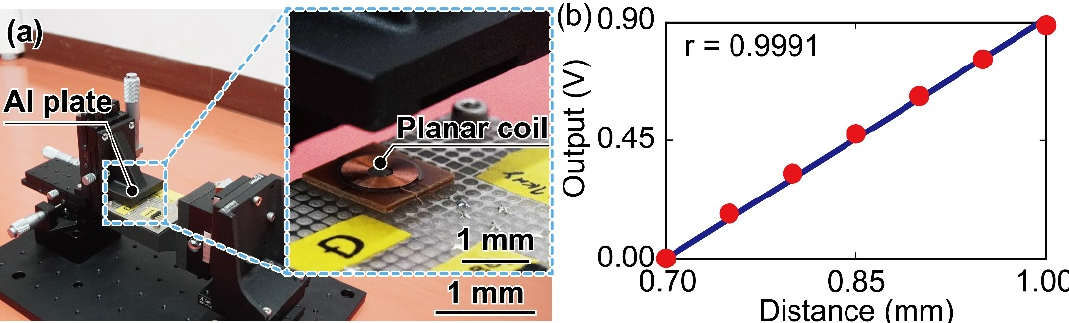
Figure 7. ( a ) Photograph of the experimental setup to calibrate the eddy current displacement sensor. ( b ) Relationship between the sensor output and the distance between the planar coil and Al plate.